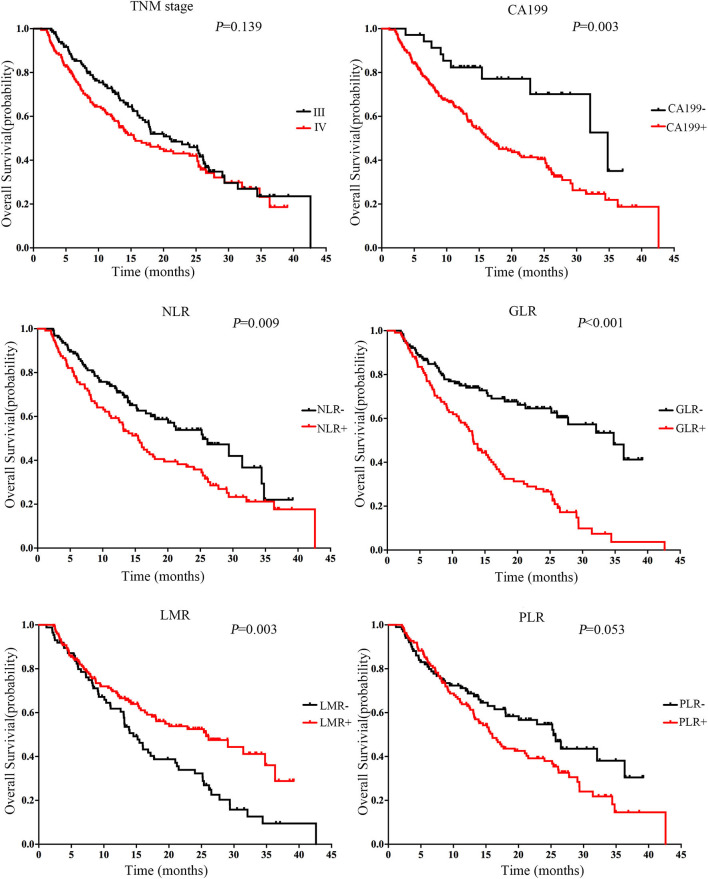
Association between markers and overall survival (OS) in patients with inoperable pancreatic cancer in the training cohort (N = 238). Kaplan-Meier curves for OS of all cases in the training cohort. The median level was selected as the cut-off between the low and high levels. The P-value was determined using the log-rank test.